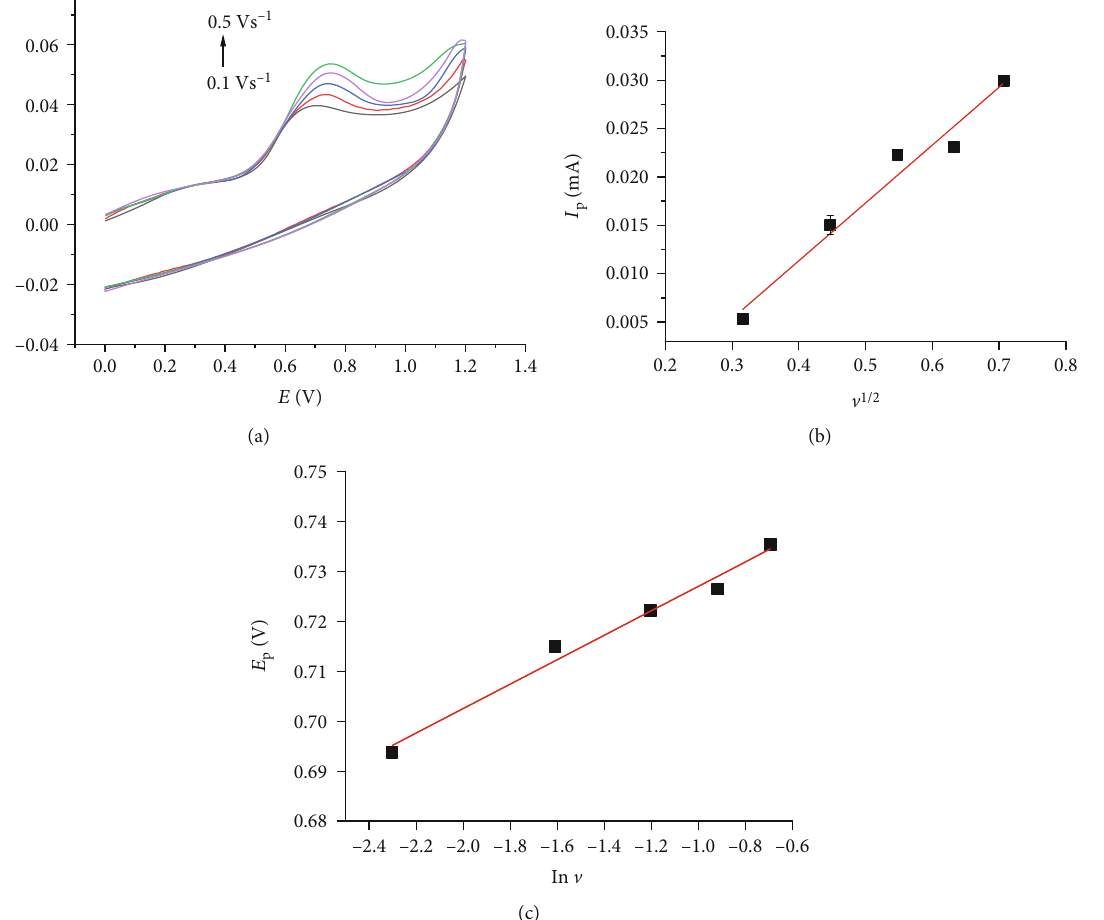
N (a), the plot of I p vs. v 1/2 (b), and E p vs. ln v (c). 3 4